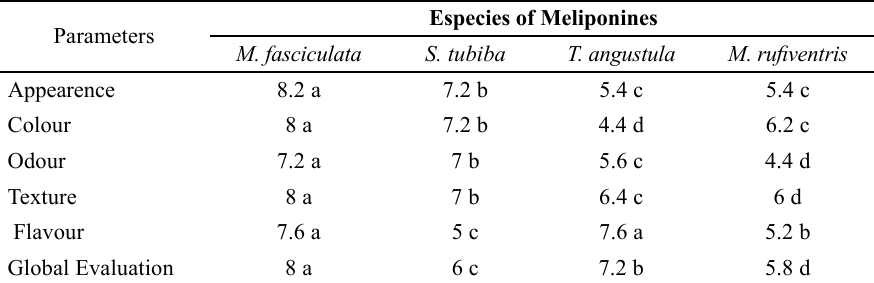
Table 5 - Sensory analysis of honey produced by stingless bees in the municipalities of Palmas and Miracema in the two harvest